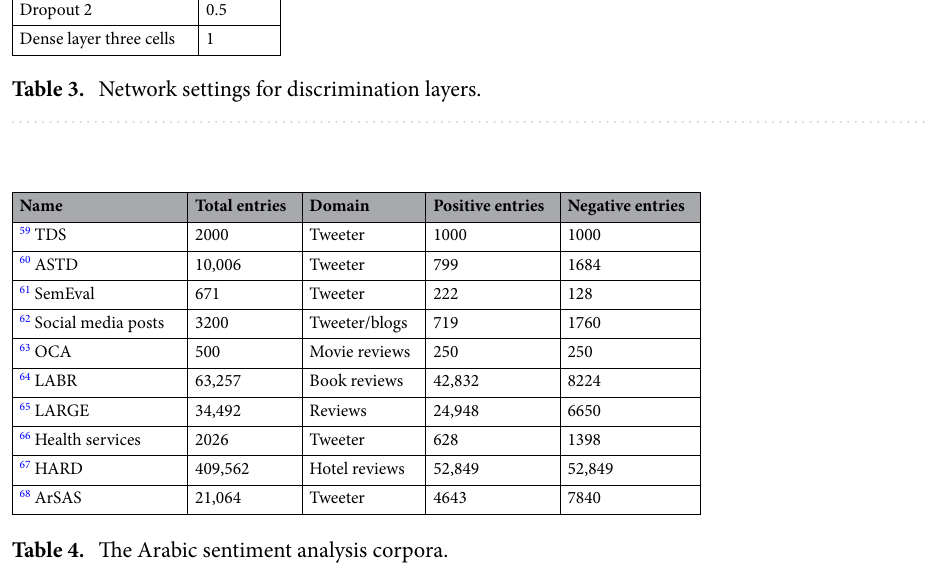
Table 4. The Arabic sentiment analysis